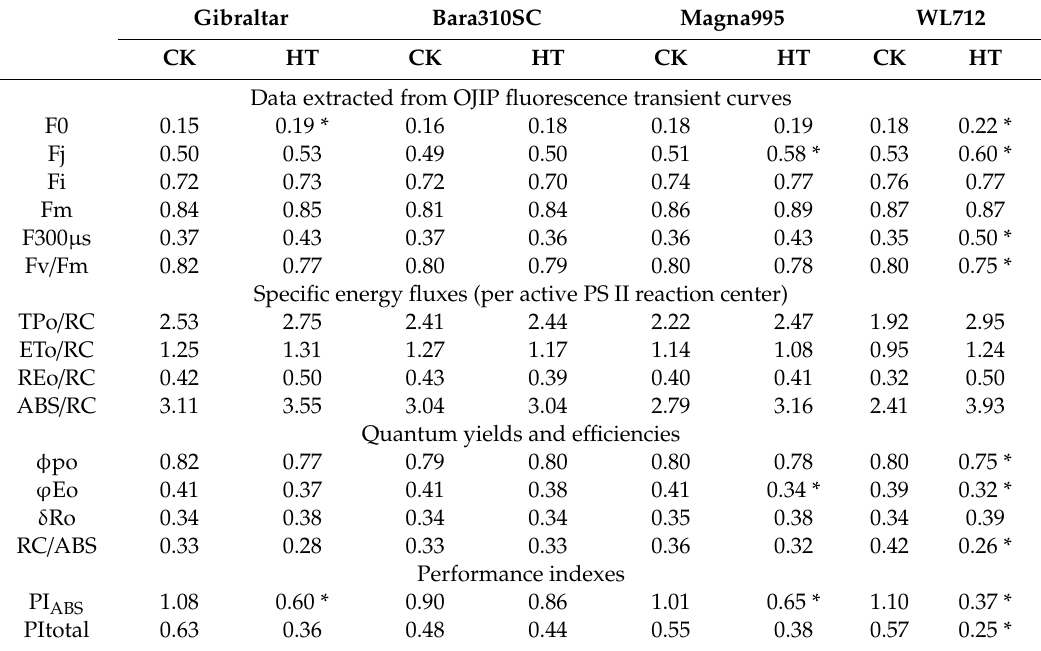
Table 6. Photosynthetic parameters extracted from OJIP fluorescence transients. Gibraltar Bara310SC Magna995